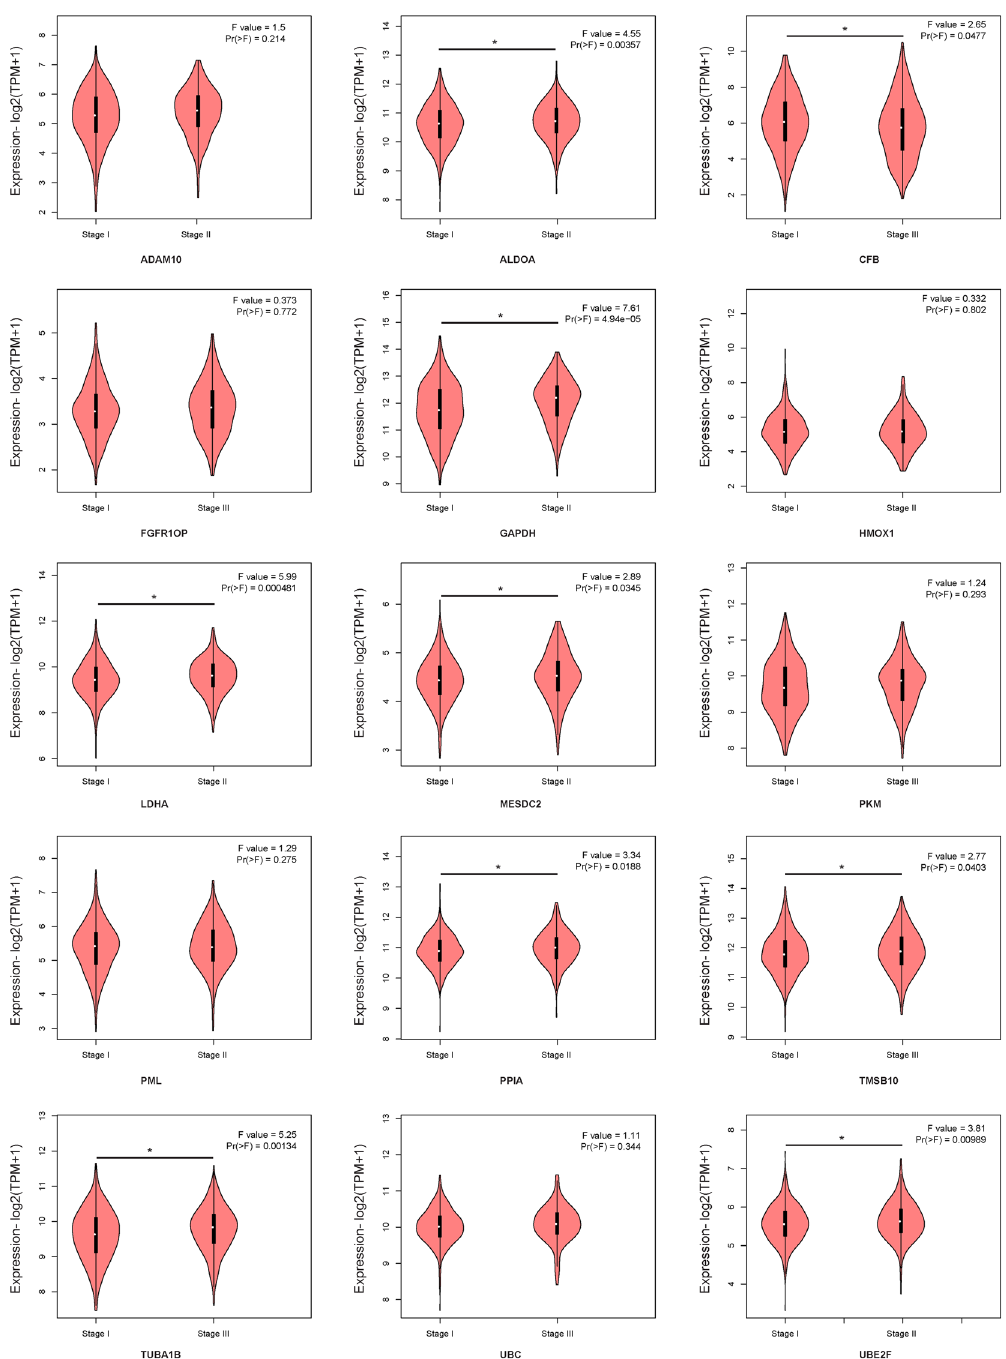
Figure 11. GEPIA online software verified the expression of the fifteen-mRNA signature in stage I/II patients with lung adenocarcinoma and lung squamous cell